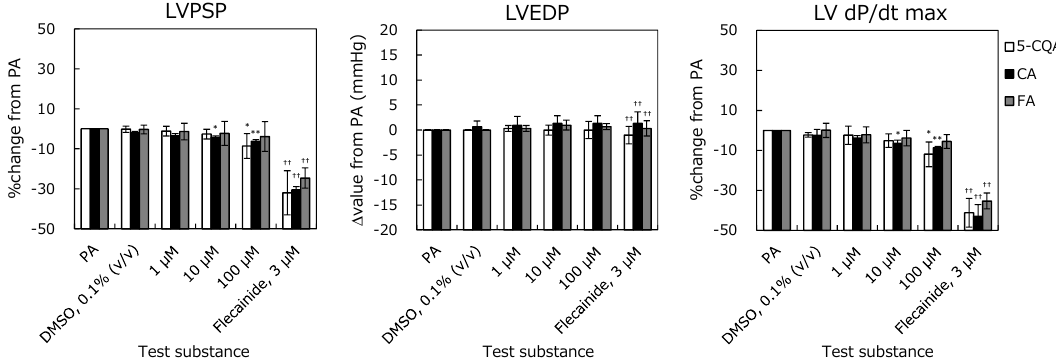
Figure 3. Relationships between left ventricular pressure (LVP) parameters and concentrations of 5-CQA, CA, and FA in the isolated perfused guinea pig heart system. Left-ventricular Peak Systolic Pressure (LVPSP), Left-ventricular End Diastolic Pressure (LVEDP), and left-ventricular-pressure rise (LV dP/dt max) are represented as % change from PA. Each error bar represents mean ± SD (n = 3). *: p < 0.025, **: p < 0.005; Significantly different from DMSO (Williams test). †† : p < 0.01; Significantly different from DMSO (Student’s t-test).